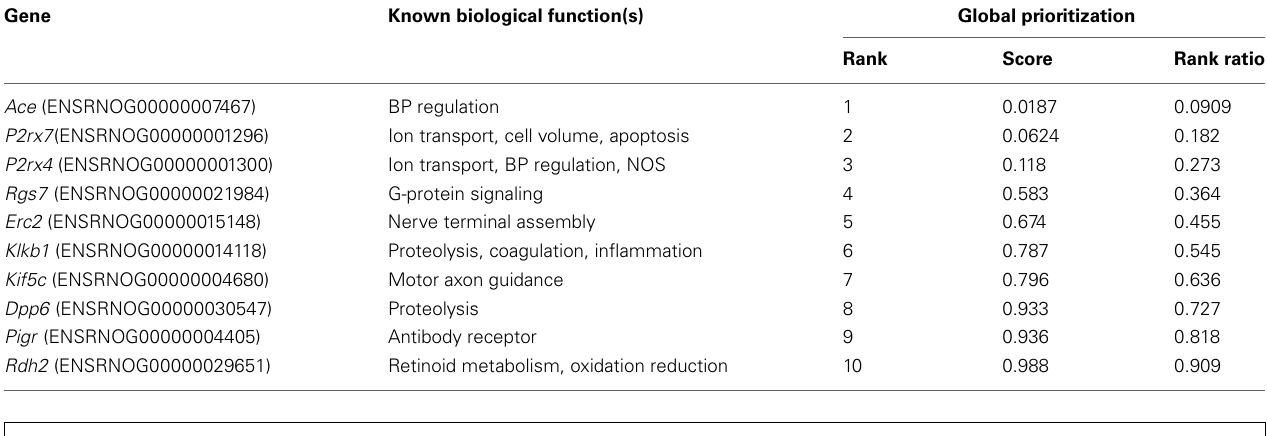
Table 2 | Global prioritization by the Endeavour enrichment method. Gene